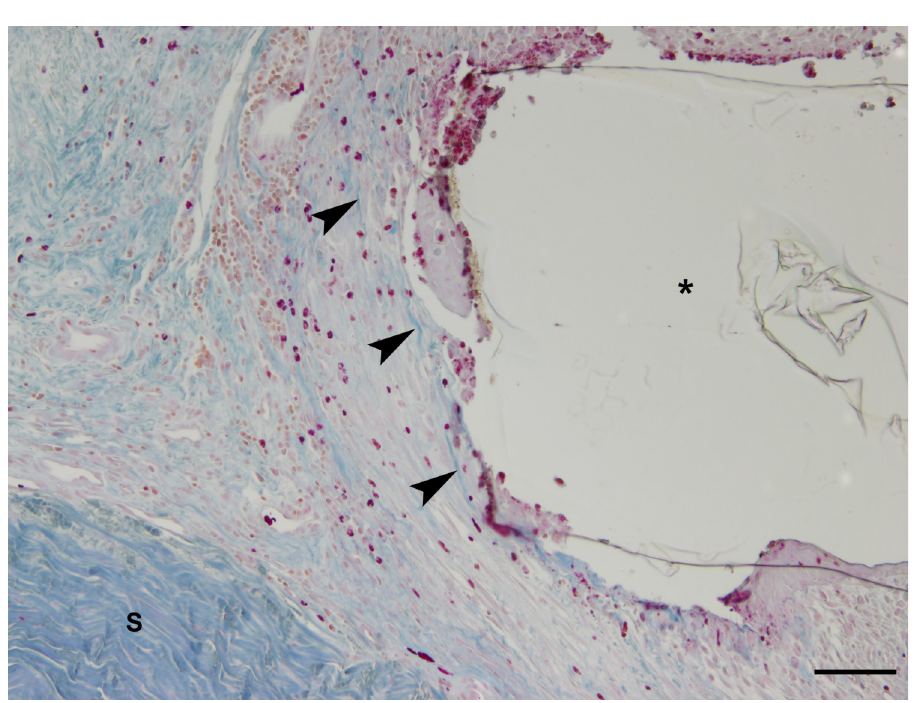
Fig 11. Fibrosis surrounding the implant area. The tissue surrounding the implant area (asterisk) is characterised by strands of spindle-shaped fibroblasts admixed with fine bundles of blue-stained collagen fibres (arrowheads). Note the dense fibrous tissue of the normal sclera (S); Azan staining; bar 100 μ m.